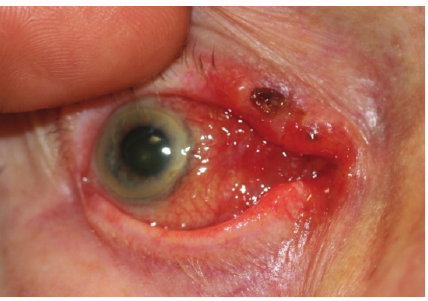
Figure 2: Thickened conjunctiva and caruncle showing red